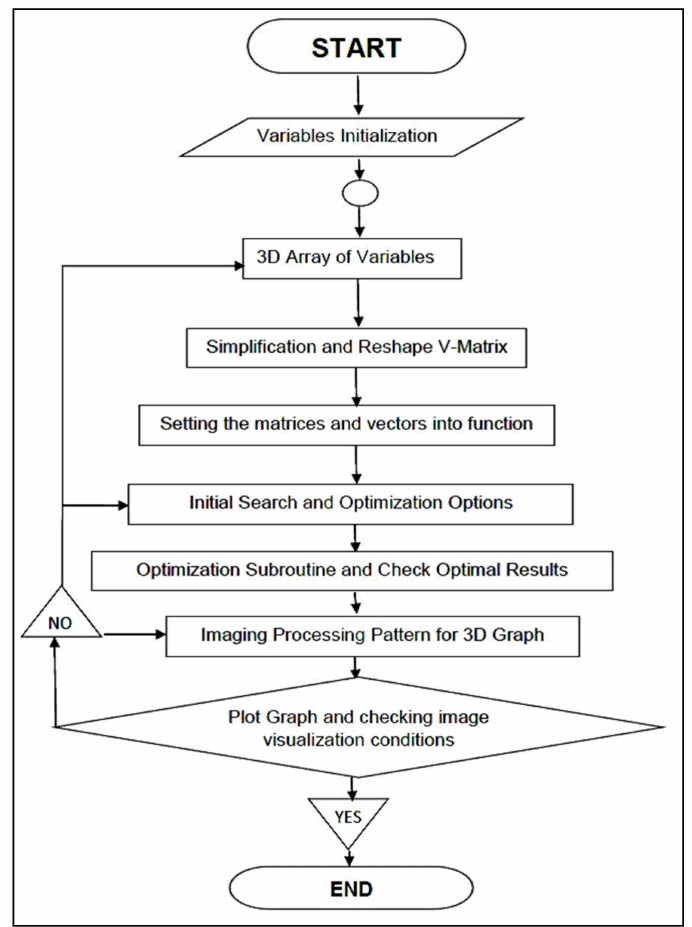
Diagram 1. Basic program structure for software. Optimization-specific programs differ for every